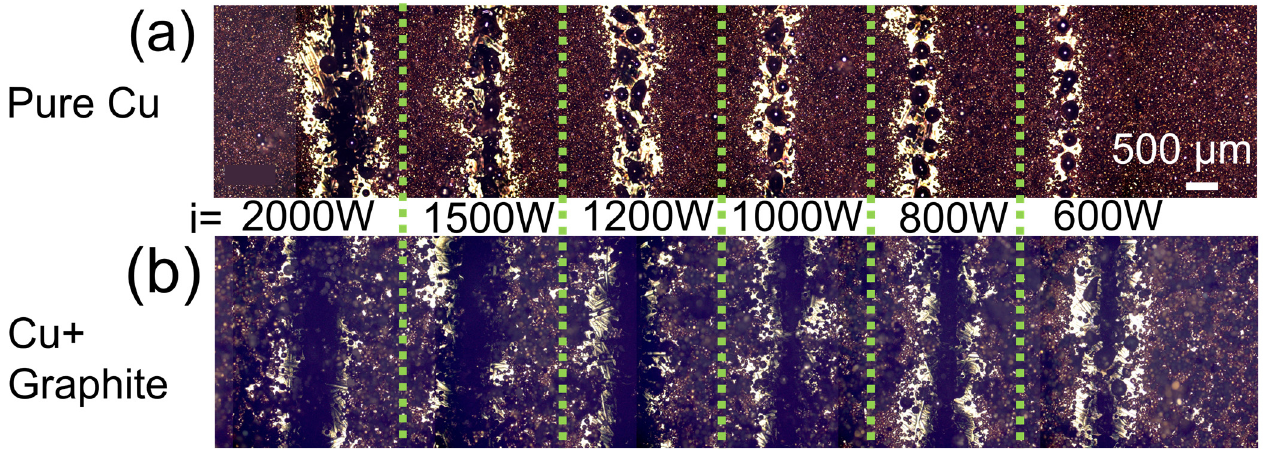
Figure 2. Optical images of the powder bed of after fusion using several laser powers. ( a ) Pure Cu powder (PCu-i), and ( b ) Cu powder covered with graphite spray (C-i) where i is indicated in the image. The scale in ( a ) is common for ( b ).